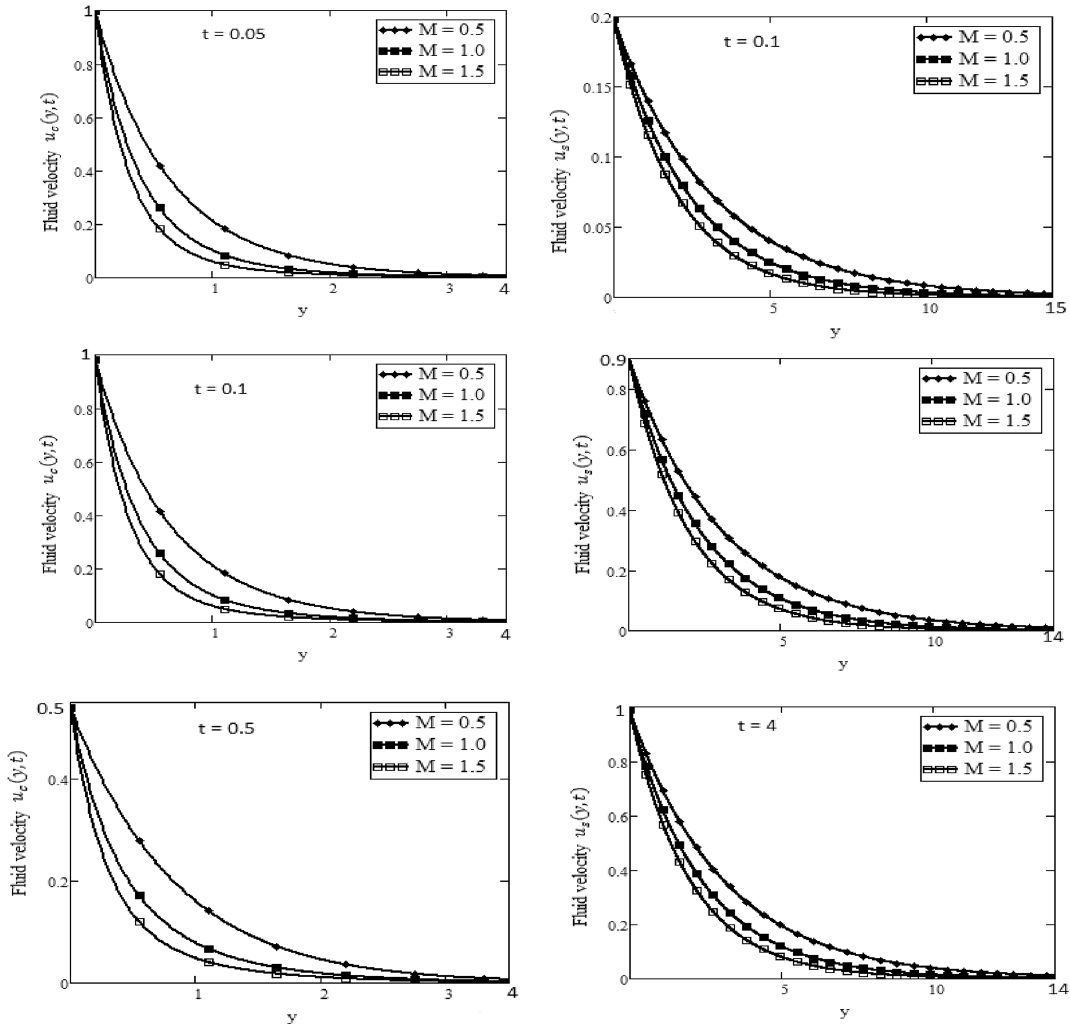
Figure 3. Velocity plot in the form of cosine and sine oscillation or various values of M of at t , when Pr = 7 , α = 0.5 .